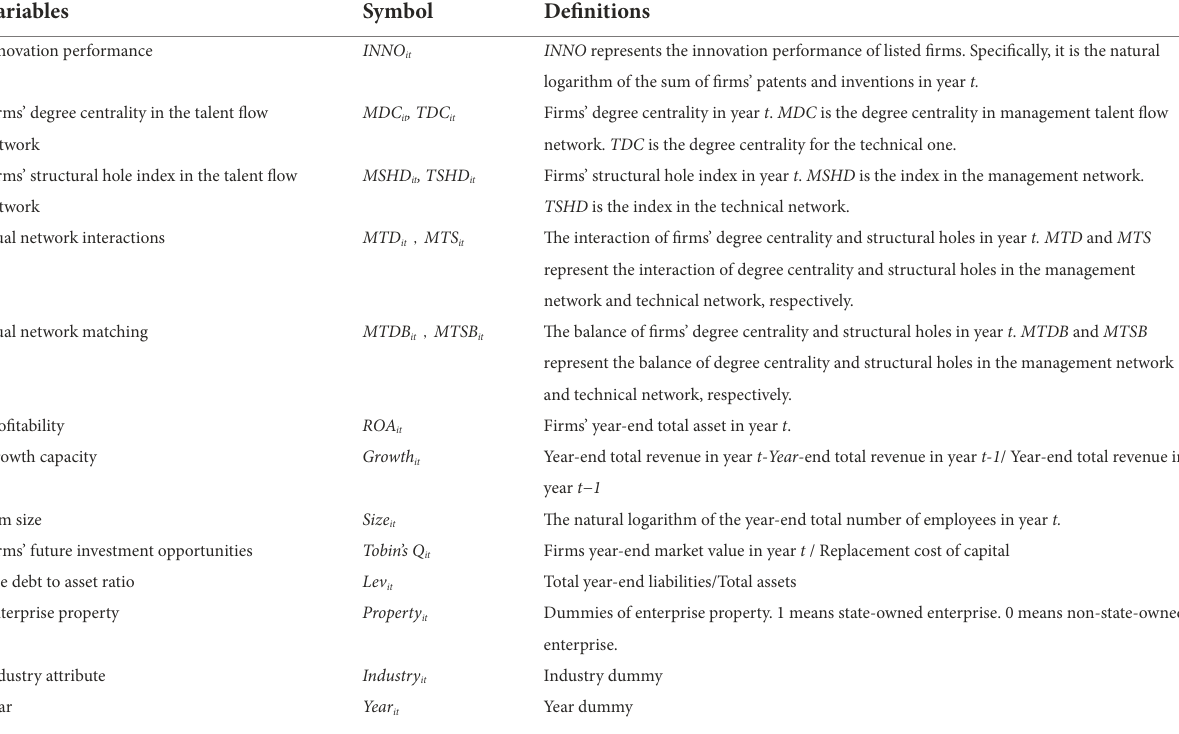
TABLE 1 Definitions of the main variables. Variables Symbol Definitions